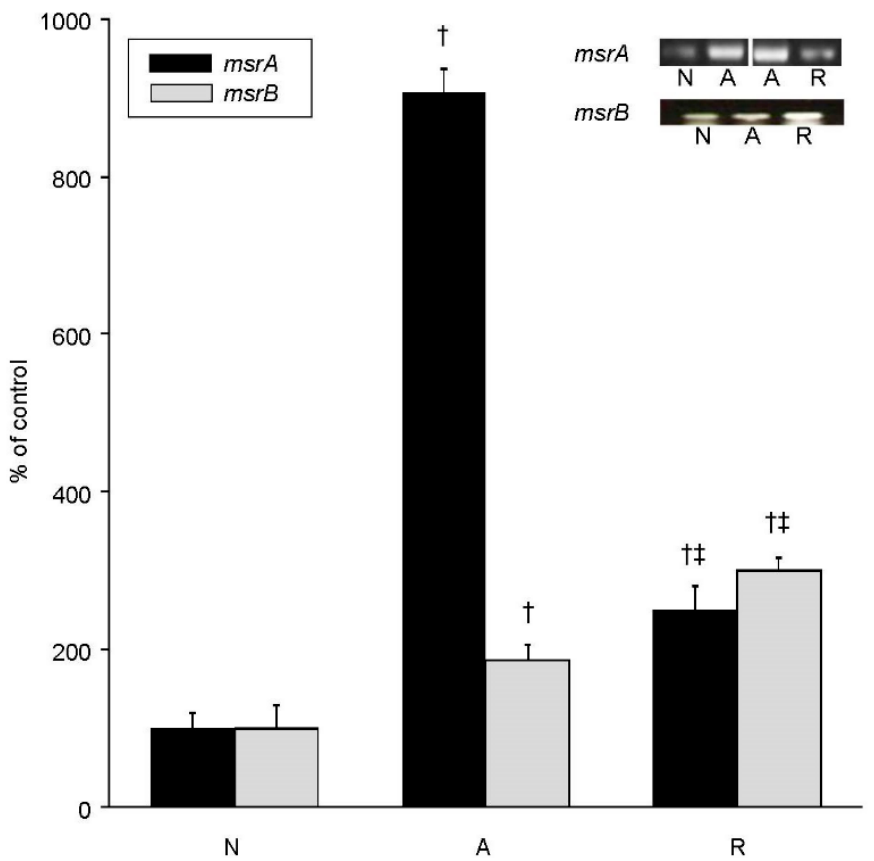
Figure 1. In vivo changes in msrA and msrB2 transcript levels in the whole brain of T. scripta . Representative gels of semi-quantitative RT-PCR for msrA and msrB2 and densitometric analysis of mRNA levels expressed as percent of normoxic control. N = normoxic controls, A = 4 h of anoxia, R = 4 h of anoxia/4 h of reoxygenation. Statistics: † = significantly different from normoxic controls, ‡ = significantly different from anoxia ( p < 0.001, n = 3–5 individuals/treatment). Even though the significant increases in Msr levels observed suggest a neuroprotective role for both MsrA and MsrB during anoxia and/or reoxygenation, the mechanism by which these increases occur is still unknown. Studies in C. elegans have shown that daf- 16, a homolog to the transcription factor FOXO3a, enhances MsrA transcription during conditions of oxidative stress, and in results already published, we showed that foxo3a transcript levels increase in vitro in anoxia and under conditions of oxidative stress [57] in primary cell cultures derived from whole turtle brains. As this increase protects the cells against severe oxidative stress, we thus looked to see if the same drivers of foxo expression would also affect Msr levels in whole brain primary